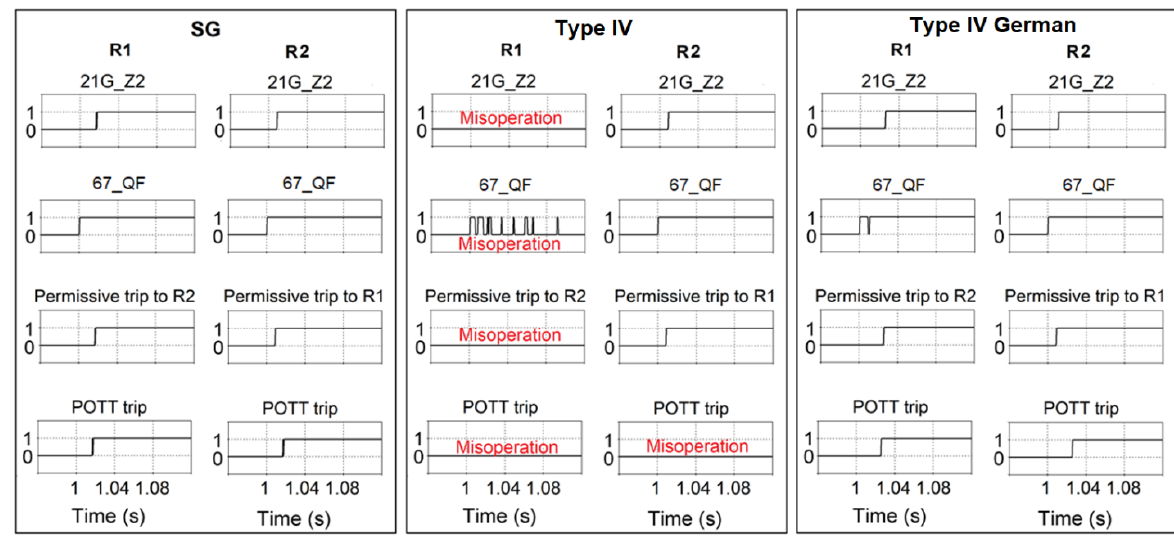
Figure 9. Response of POTT to a ground fault on the protected line under SG, Type IV-based IBR with no I2 control, and Type IV-based IBR with I2 control based on the German code.